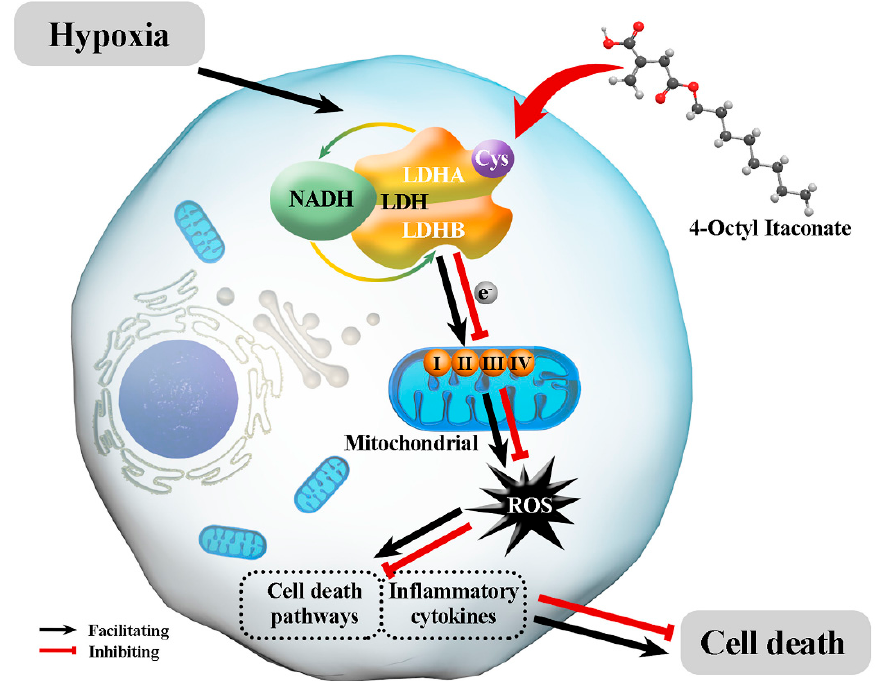
Figure 6. A proposed mechanism for the protective effects of 4-OI on MIN6 cells damaged by hypoxia and oxidative stress: Hypoxia promotes the interaction of NADH and LDH to generate electrons, which pass through the mitochondrial oxidative respiratory chain complex I, II, III, IV to produce reactive oxygen species. ROS activates multiple cell death pathways and increases the release of inflammatory factors, ultimately leading to cell death. Treatment with 4-OI decreases the enzymatic activity of LDH by alkylating LDHA and reducing ROS generation, thereby reducing oxidative stress and minimizing hypoxic damage.